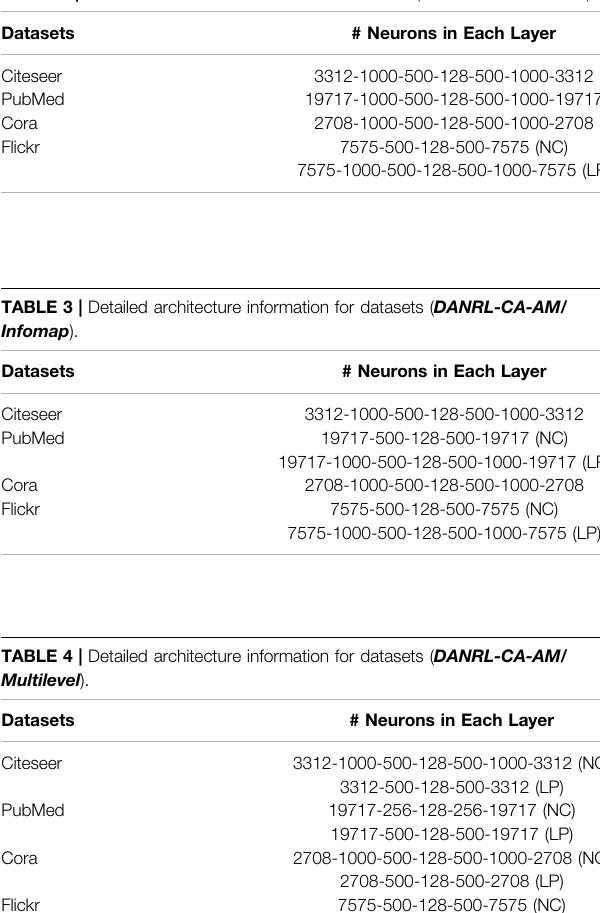
TABLE 2 | Detailed architecture information for datasets ( DANRL-CA-AM/LPA ).